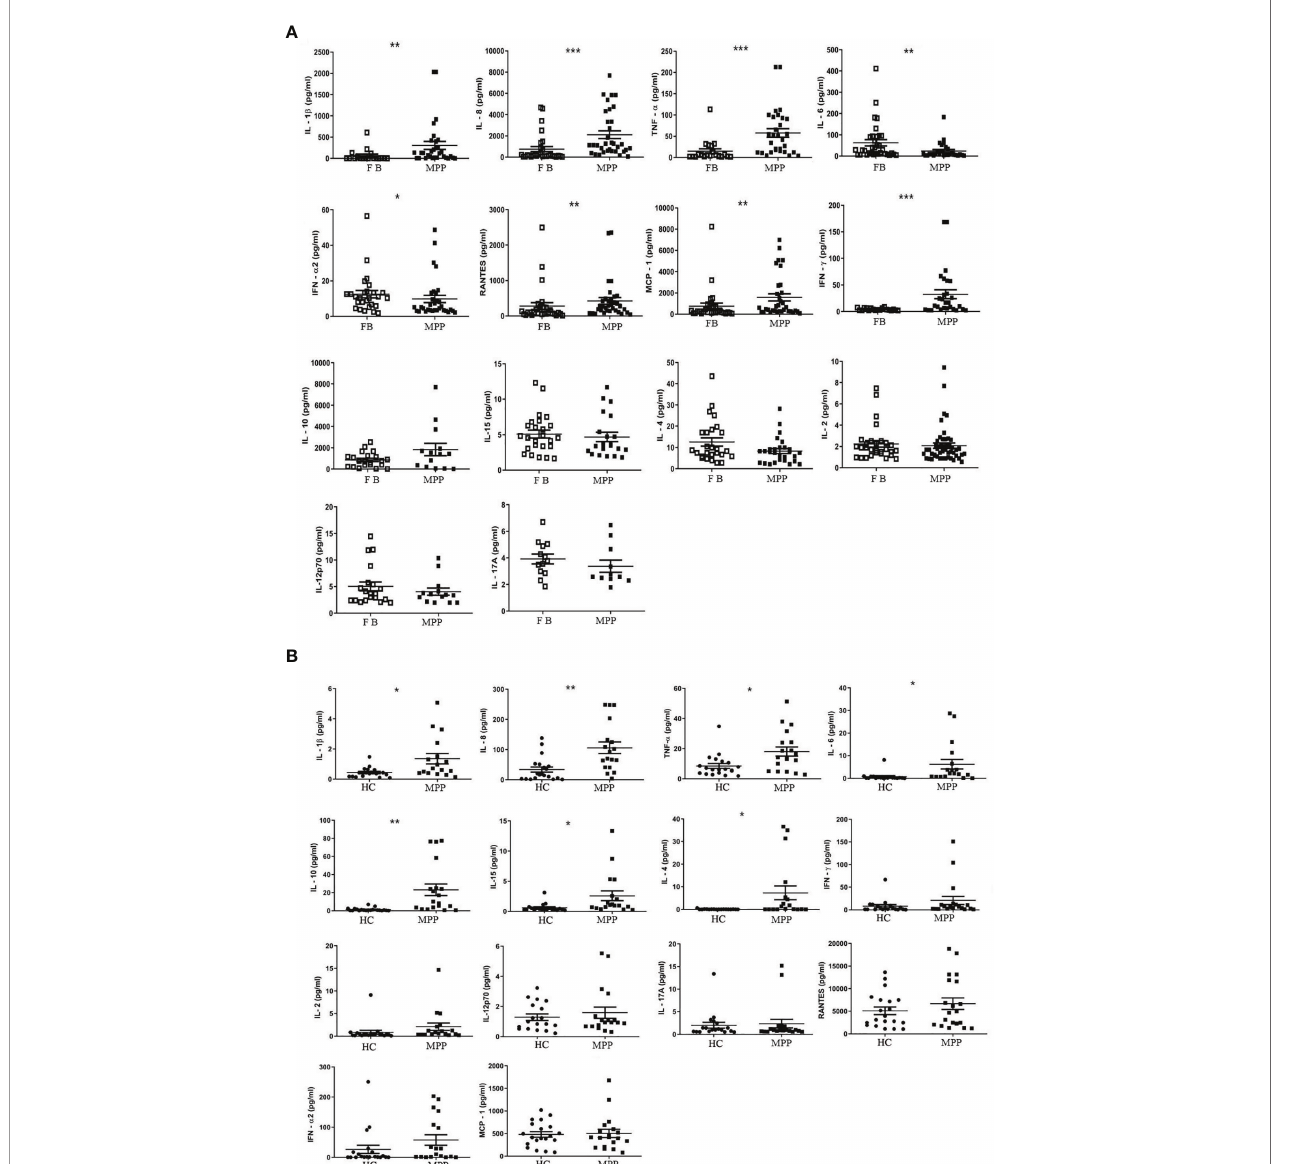
FIGURE 2 | The absolute concentration (pg/ml) of each indicated cytokine in (A) aqueous phase of BALF or in (B) serum was determined via Luminex xMAP technology by a calculation based on a standard curve generated from the quanti fi cation standards of each cytokine the manufacture provided. Student ’ s t -test was employed to analyze the difference of the cytokine concentration in (A) BALF between patient group (MPP) and control group (FB) and (B) in serum between patient (MPP) and control group (HC). * p < 0.05; ** p < 0.01; *** p <